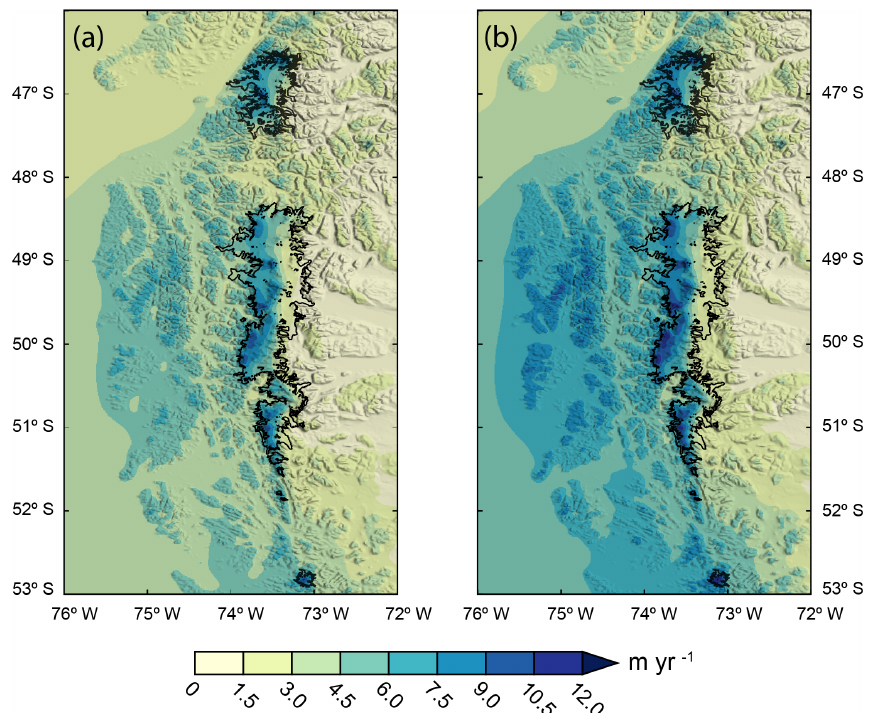
Figure 3. Results of the OPM ensemble experiments. Mean precipitation fields (2010–2016) simulated by the OPM using (a) the “realistic” (OPM 0 . 45 ) parameter setup and (b) the “extreme” (OPM 0 . 60 ) parameter setup using a DR of 0.6 and the 98th percentile values for the uplift sensitivity factor ( C w = 0 . 004) and moist stability frequency ( N m = 0 . 007s − 1 ).